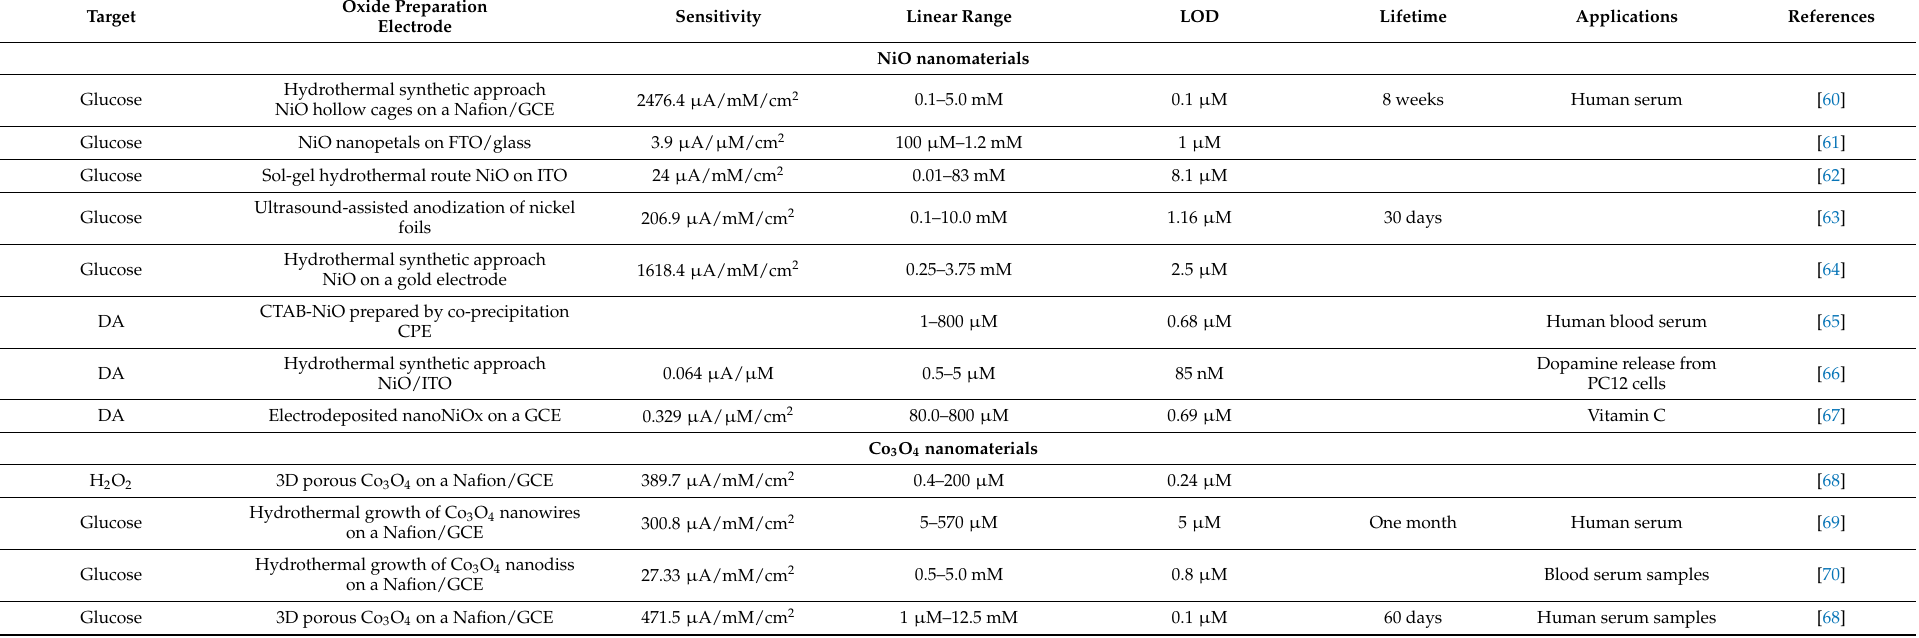
Table 4. Nickel oxide and cobalt oxide-based electrochemical sensors for the detection of bioactive